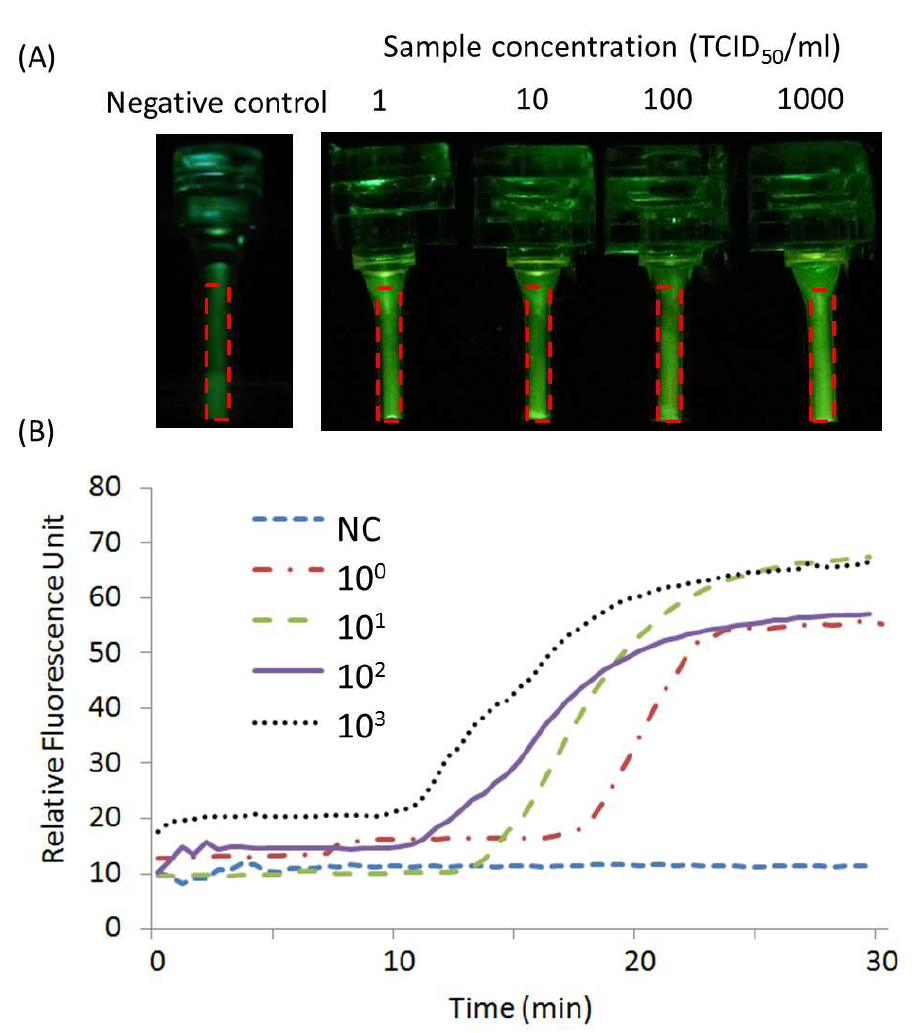
Figure 8. Real-time CPCR with H1N1 templates. Real-time curves of intensity of fluorescence sig- nal with diluted samples. In details: ( A ) end-point fluorescent images of amplicons with different concentrations and a negative control (NC); ( B ) analyzed real-time fluorescence curves, the short-dashed line, dashed and dotted line, long dashed line, solid line, and dotted line, respectively, correspond to negative control (NC), and samples with different concentrations from 1.0 to 1000 TCID 50 /mL.